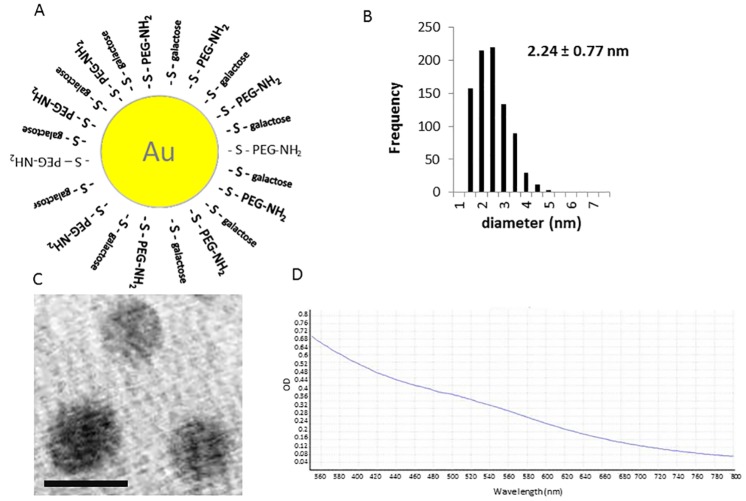
Characteristics of PEG-amine/galactose gold nanoparticles.(A) Schematic of nanoparticle organization. (B) Size distribution of nanoparticles (mean size ± s.d.). (C) High resolution electron microscopy of <4 nm nanoparticles (scale bar = 5 nm). (D) Absorbance spectrum of the nanoparticles.